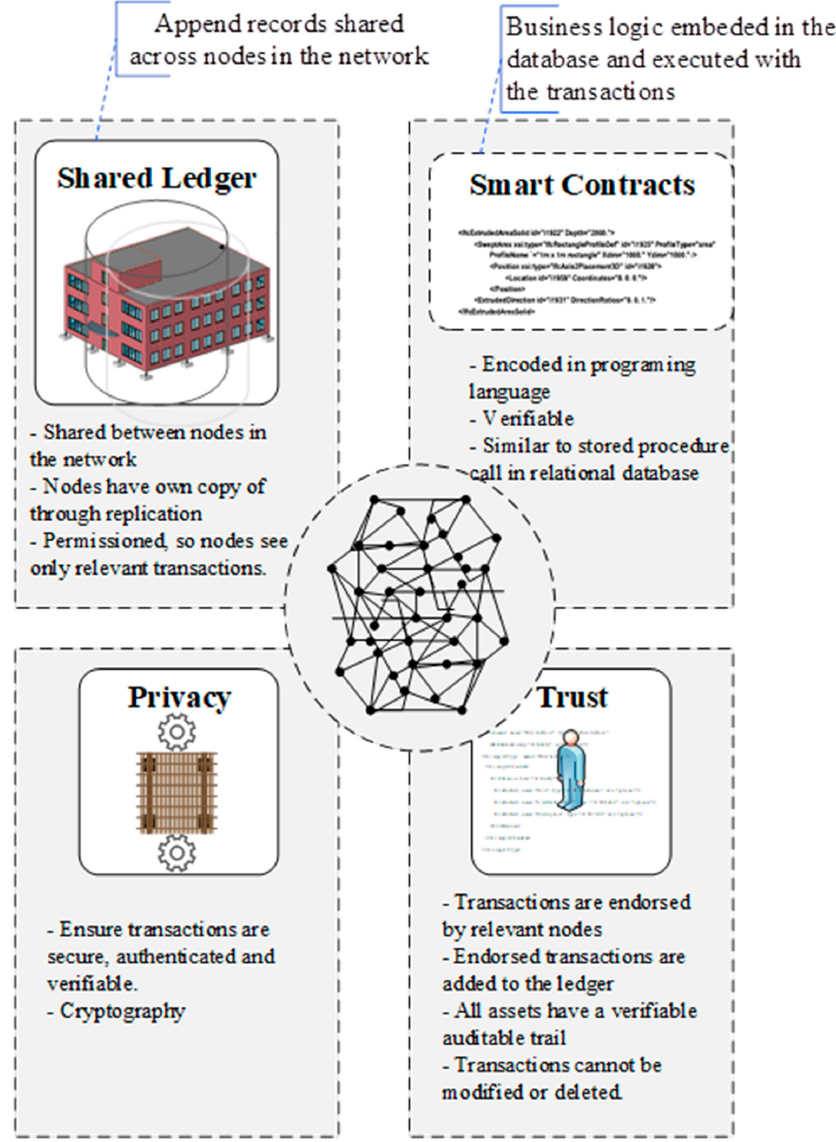
Figure 4. Main components of BCT.